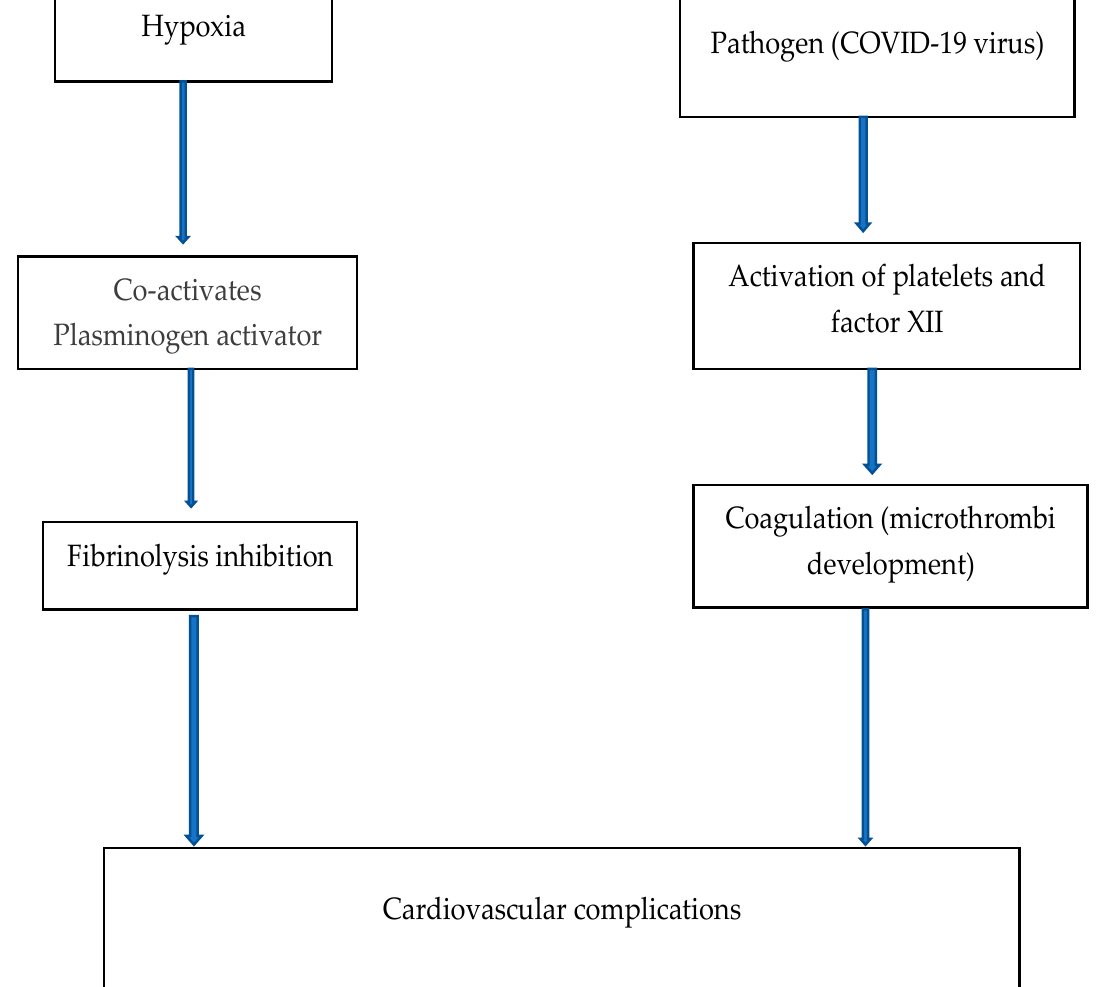
Figure 5. Diagrammatic illustration of prothrombotic state and hypercoagulability mechanism.